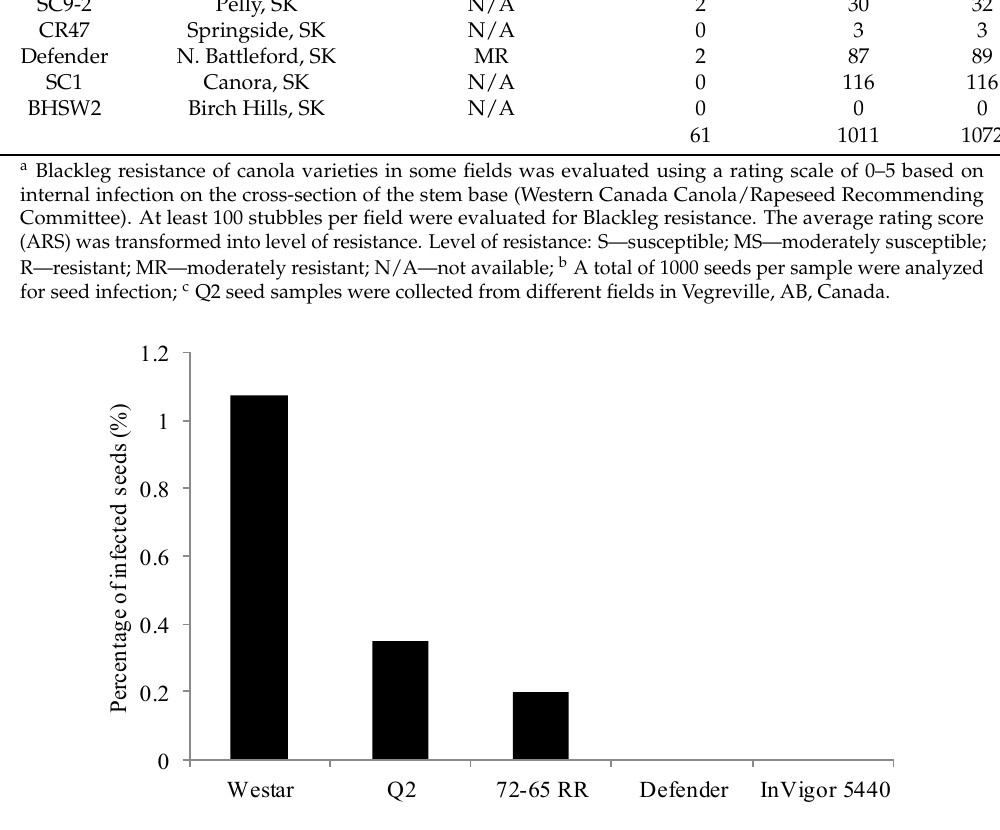
Figure 3. Percentage of Leptosphaeria maculans infected seeds in canola samples with different level of Blackleg resistance. Level of resistance: S—-susceptible; MS—-moderately susceptible; R—-resistant; MR—-moderately resistant. Westar: S; Q2: MS; 72-65RR: R; Defender: MR; InVigor 5440: R.